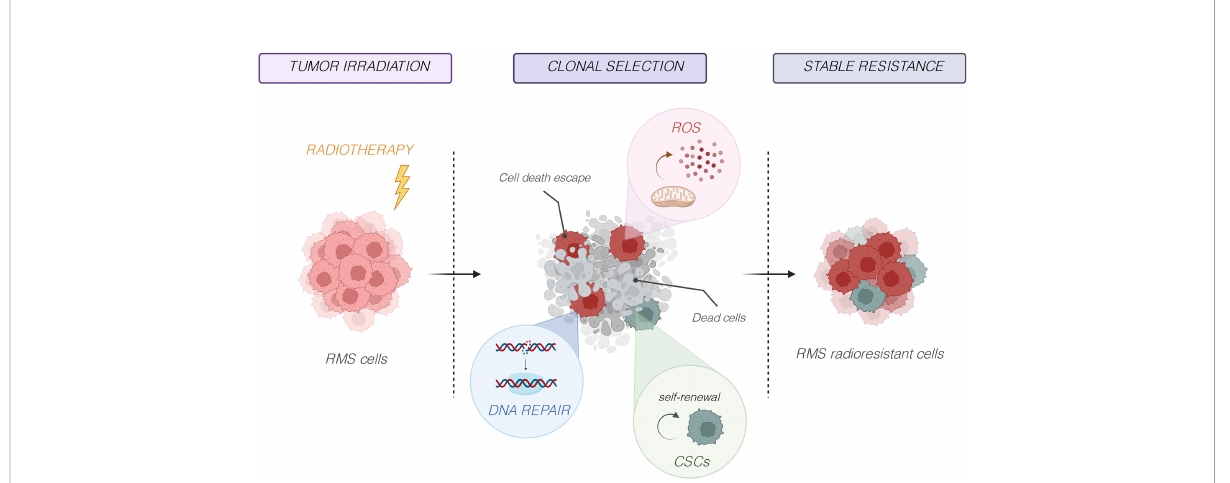
FIGURE 3 Molecular mechanisms responsible of radioresistance. Several key cellular and molecular factors, including DNA damage and repair, oxidative stress, tumor microenvironment, cancer stem cells (CSCs), and tumor heterogeneity, are implied in RMS